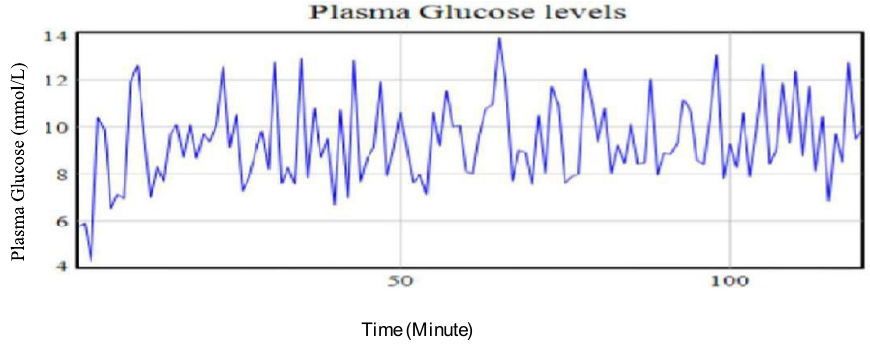
Figure 7. Plasma glucose levels of a type II diabetic patient using base run data from the CGM.